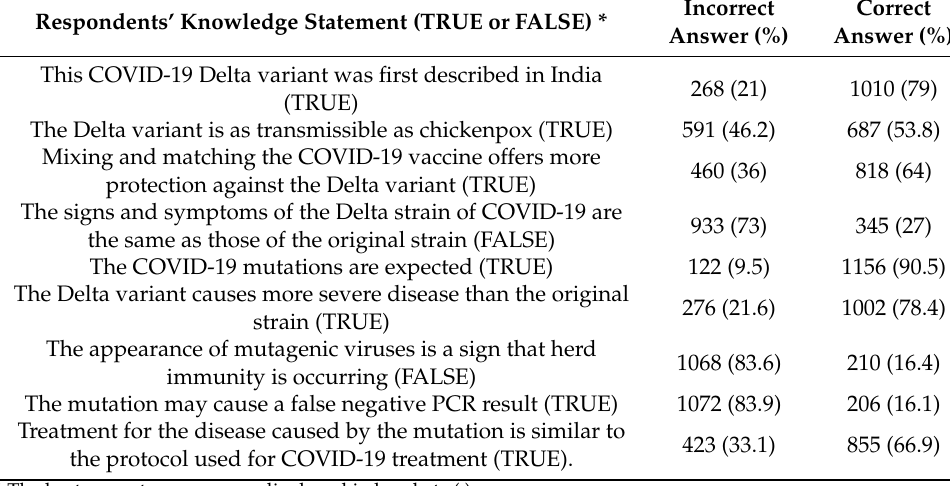
Table 5. Respondents’ knowledge score for the Delta COVID-19 variant.